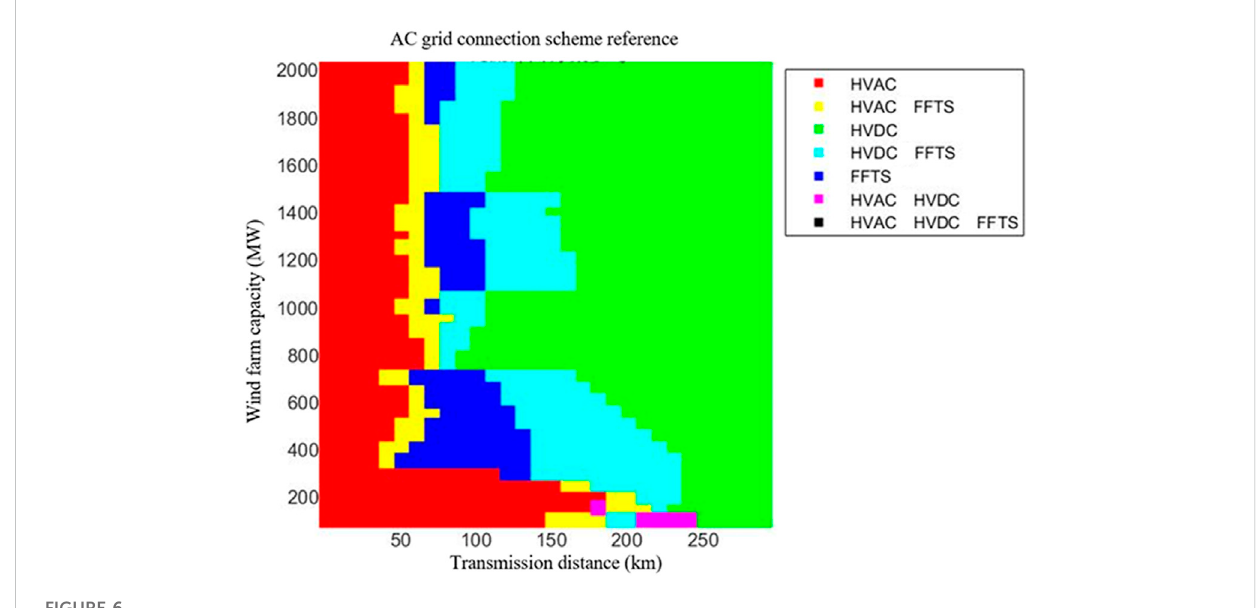
FIGURE 6 AC grid connection scheme